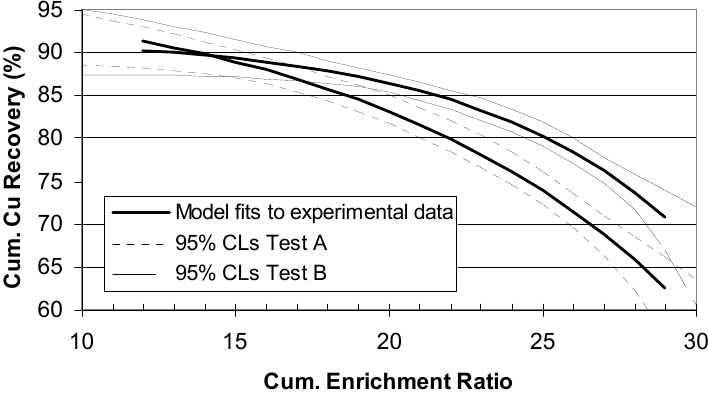
Figure 2. Bootstrapped 95% confidence intervals on the grade-recovery curves of Figure 1 (from [3] with permission).